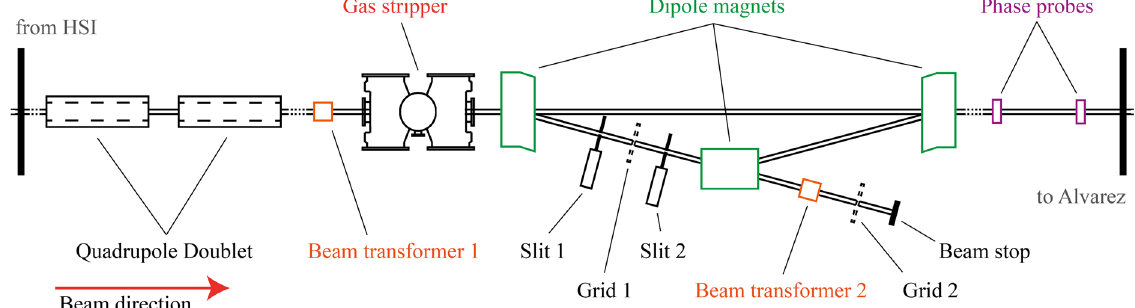
FIG. 1. Schematic of the gas stripper section at the GSI UNILAC: The charge state separation is achieved using a system of three dipole magnets. The ion beams are horizontally focused through the stripper by two quadrupole doublets onto the second analysing slit (Slit 2) behind the first dipole magnet. The beam current can be measured by several beam transformers along the beam line. The beam energy is measured with time-of-flight measurements using phase probes.